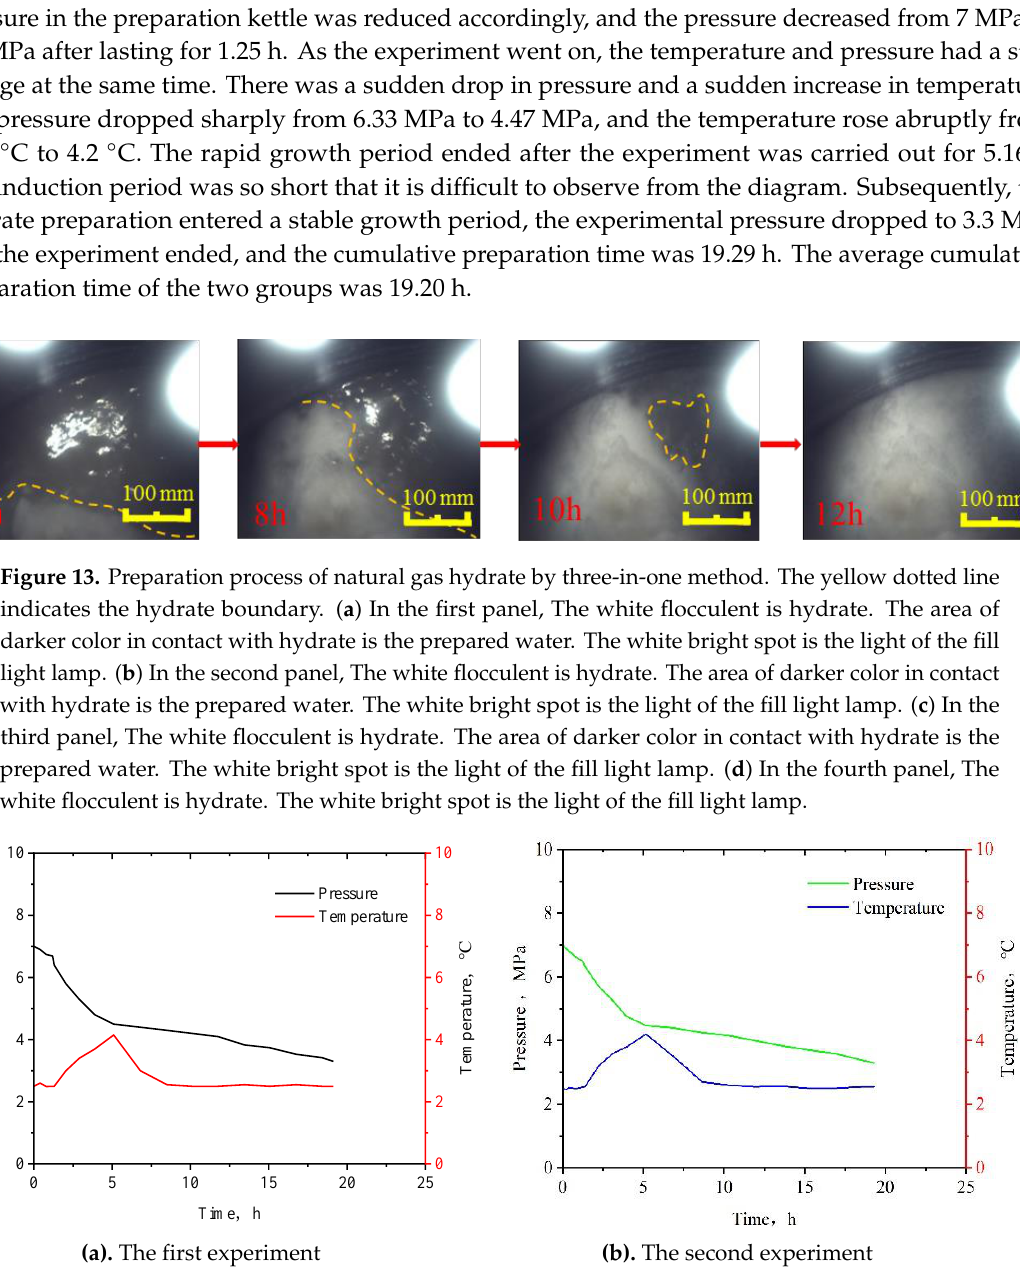
Figure 14. Temperature and pressure changes during preparation of hydrate by three-in-one method.